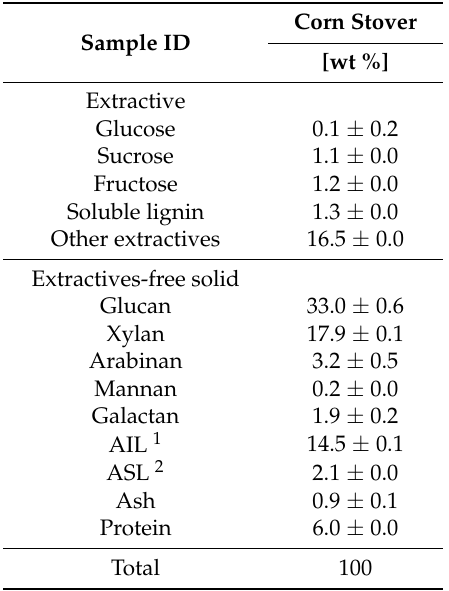
Table 1. Chemical composition of untreated corn